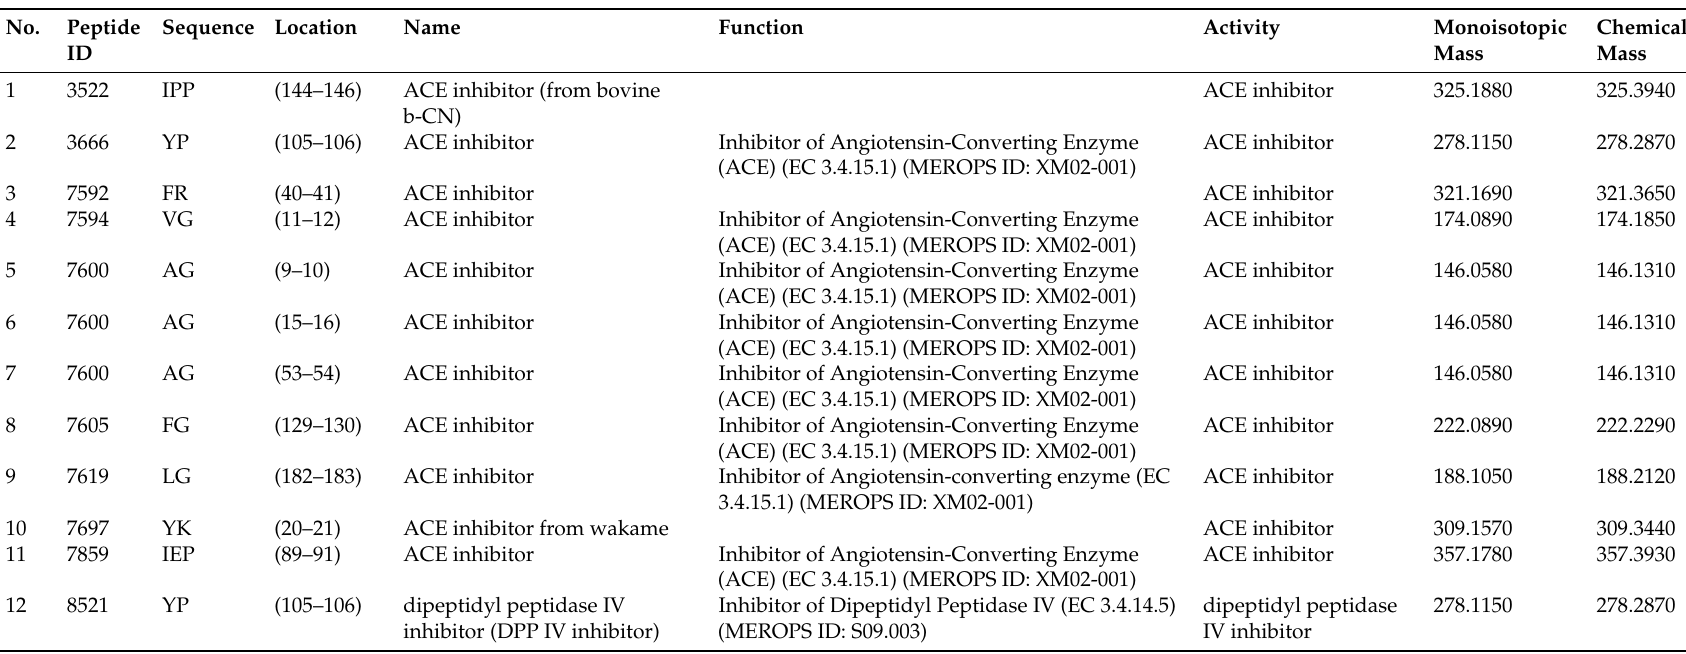
Table A15. Bioactive peptides from RubisCO of Halophila stipulacea . In silico enzymatic cleavage was carried out by using